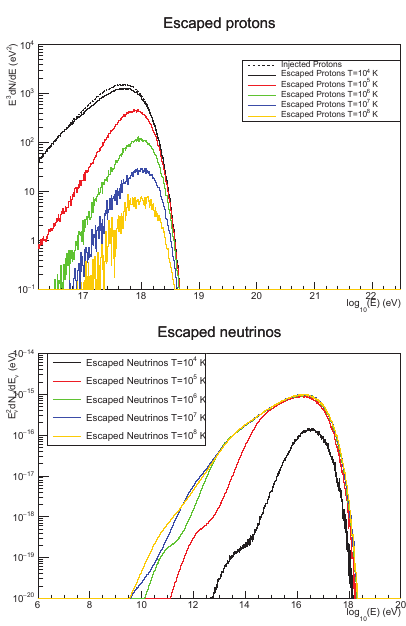
Figure 3. CR (top) and neutrino (bottom) spectra escaped from the source environment; CR fluxes are multiplied by E 3 while the neutrino ones by E 2 . The parameters at injection are γ = 1 . 5 and = 10 17 . 5 V and the mass composition is pure R max